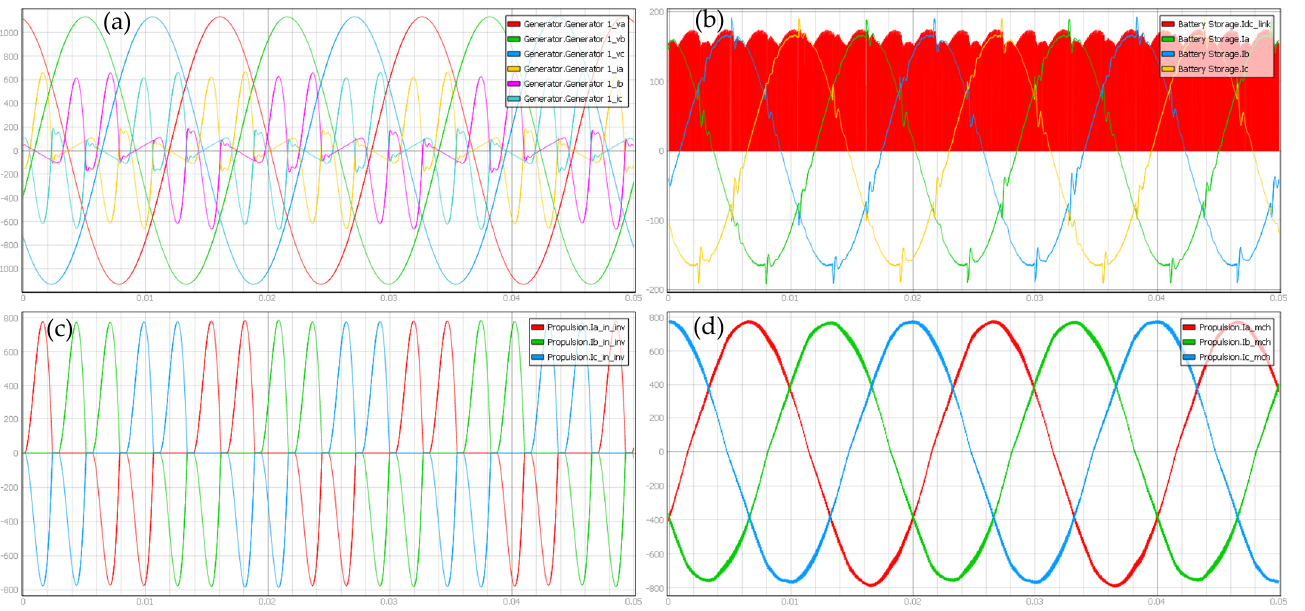
Figure 8. Results of case study 1/scenario B. From left to right, top to bottom: ( a ) diesel generator phase voltages and currents; ( b ) battery currents (at the battery itself and at the output of the filter); ( c ) input currents to the propulsion system; ( d ) stator currents of the induction motor.